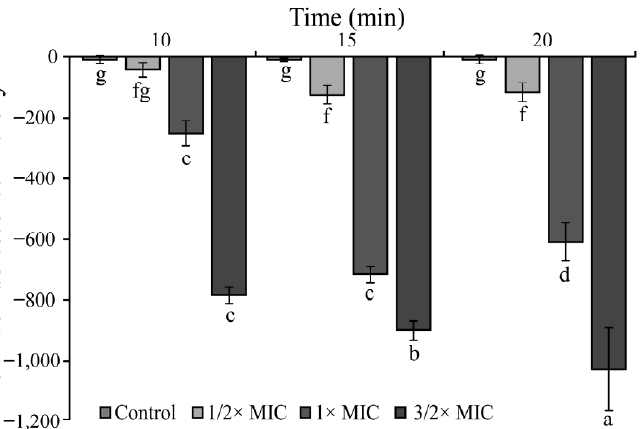
Figure 7. The effects of linalool on the membrane potentials of S. sonnei . Values represent the means of independent triplicate measurements. Bars represent the standard deviation ( n = 3). Different letters indicate a significant difference cross the figure ( p < 0.01).